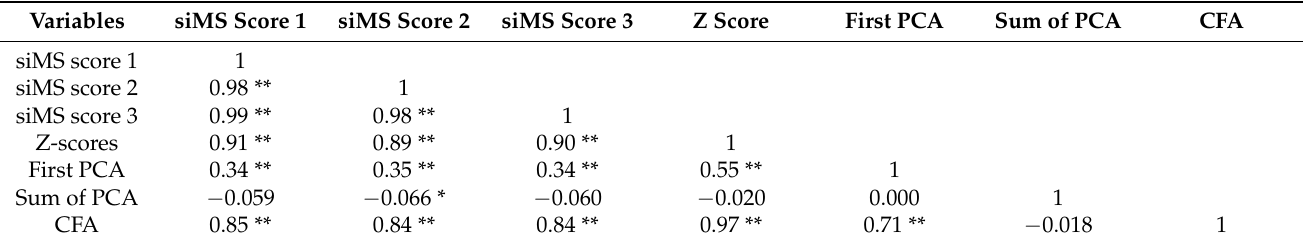
Table 3. Pearson’s correlation coefficients between seven cMetS scores approach each other.